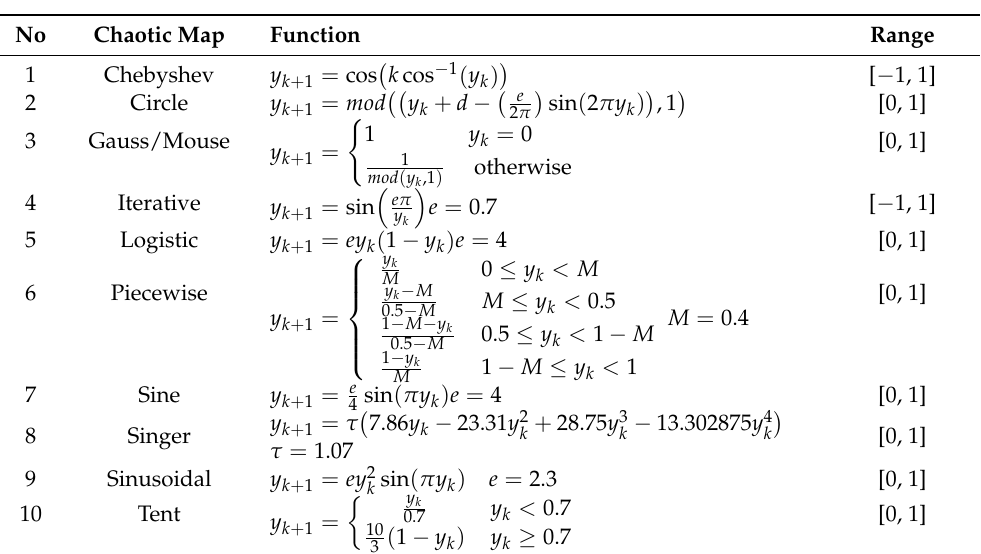
Table 1. The chaotic mapping